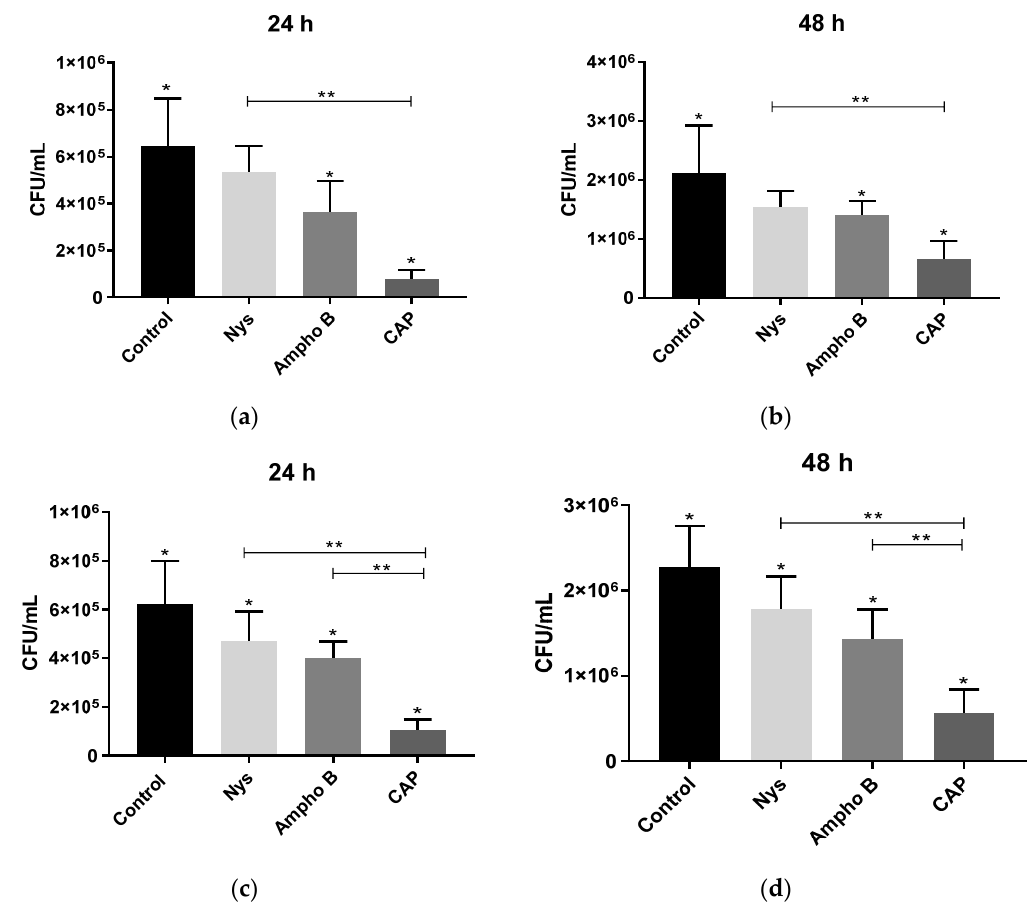
Figure 1. Values of biofilms viable cells after treatments with polyenes antifungals (nystatin, ampho B) and CAP, separately. The biofilms of 24 and 48 h of reference strain SC5314 ( a , b ) and clinical isolate P29 ( c , d ) were exposed with each treatment for 5 min. Control = no treatment; Nys = treatment with 80 µg/mL of nystatin; Ampho B = treatment with 5 µg/mL of amphotericin B; CAP = treatment with cold atmospheric plasma. (*) indicate significant differences ( p < 0.05) between the groups and the control. (**) indicate significant differences ( p < 0.05) between the treatments.